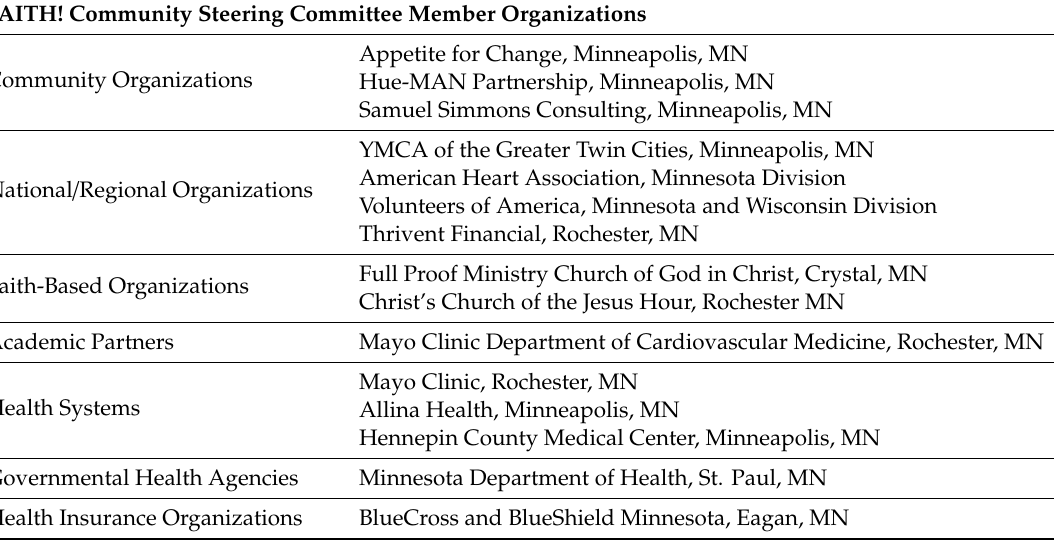
Table 1. FAITH! Community Steering Committee Member